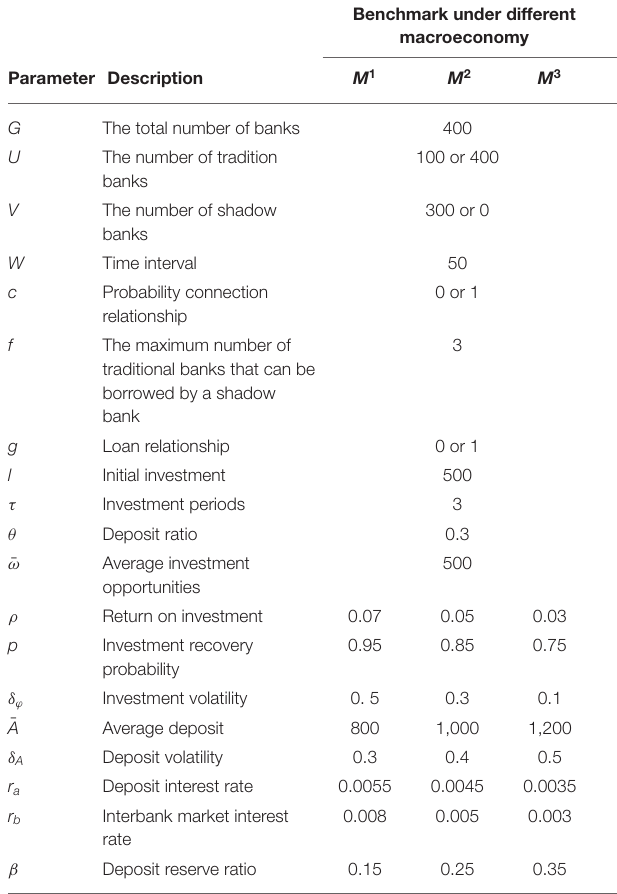
TABLE 1 | Summary of benchmark parameters of the model.